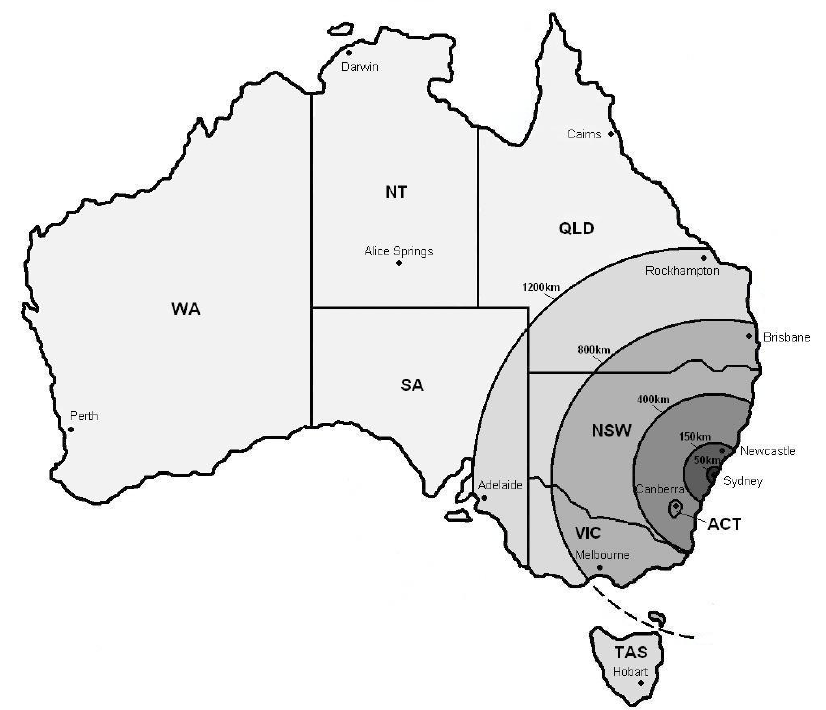
Figure 1. Distance zones from Westmead Hospital. Schematic map of Australia with states and major cities denoted. Distance rings (different areas of shading) are shown radiating from NPTU in Westmead Sydney, NSW.